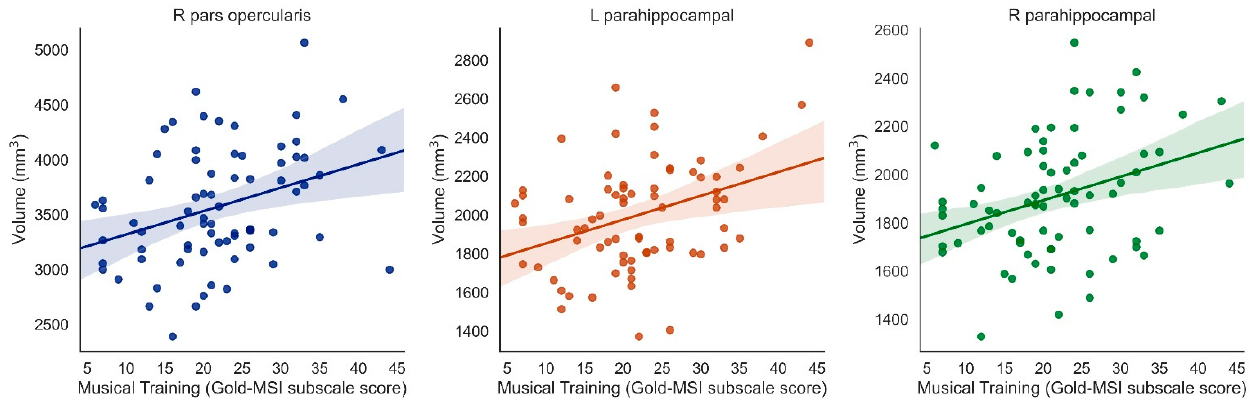
Figure 3. Significant positive associations between Musical Training (Gold-MSI) and right pars opercularis, left parahip- pocampus, and right parahippocampus (Bonferroni-corrected).